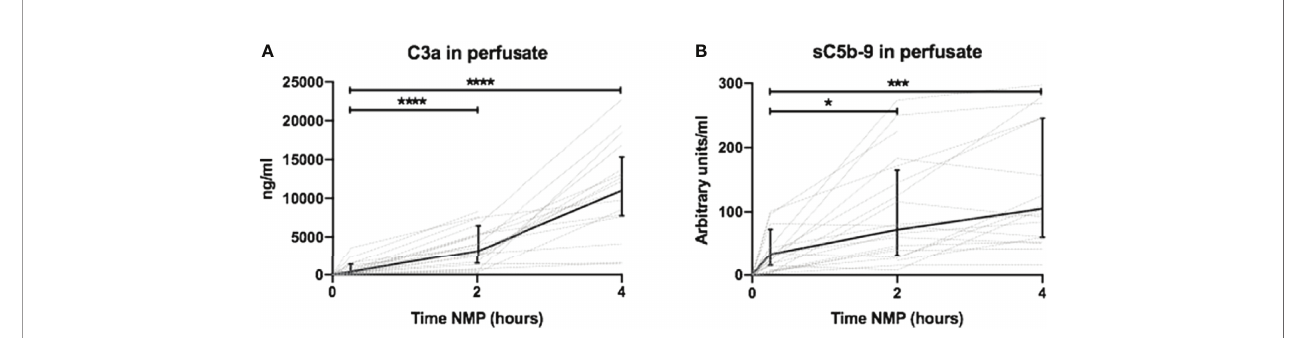
FIGURE 2 | Dynamics of complement perfusate levels during 4 h of normothermic machine perfusion of porcine kidneys. Dynamics of (A) C3a and (B) sC5b-9 perfusate levels during 4 h of normothermic machine perfusion of porcine kidneys. Perfusate levels of both C3a and sC5b-9 increase during normothermic machine perfusion of porcine kidneys. Dotted lines: increase of complement perfusate levels per individual perfused kidney. Solid lines and bars: median ± interquartile range of complement perfusate levels for all kidneys ( n = 20). * p < 0.05, *** p < 0.001, **** p < 0.0001. NMP, normothermic machine perfusion; sC5b-9, soluble